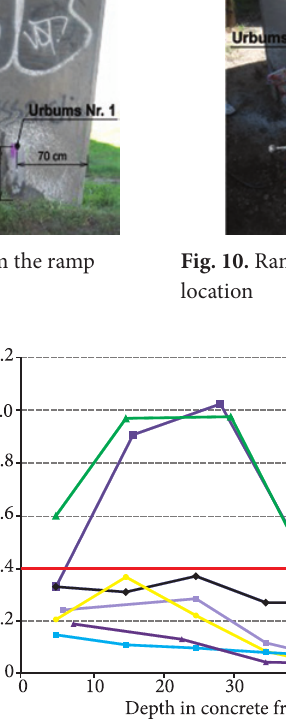
fig. 11. Chlorides in cement paste of bridge piers